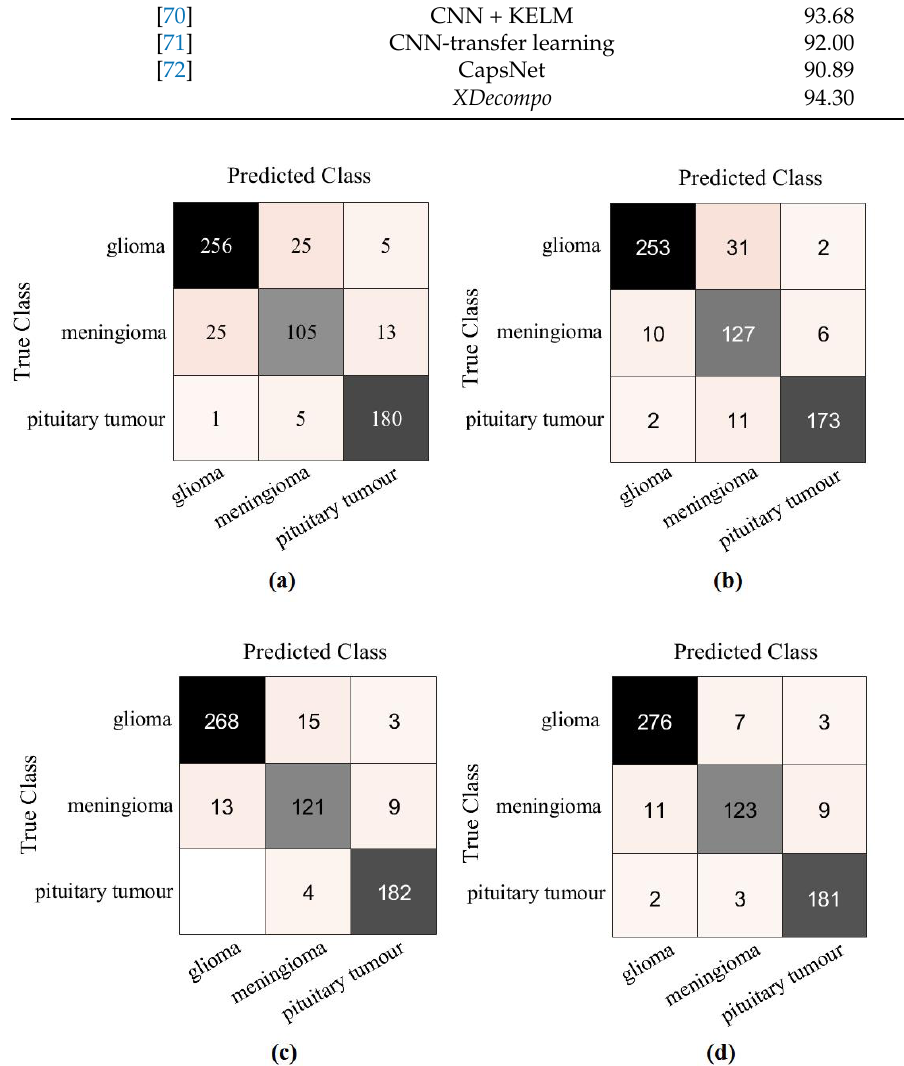
Figure 11. The confusion matrix results of Brain tumour dataset obtained by: ( a ) ResNet-50 pre- trained network, ( b ) DeTraC, ( c ) 4S-DT , and ( d ) XDecompo